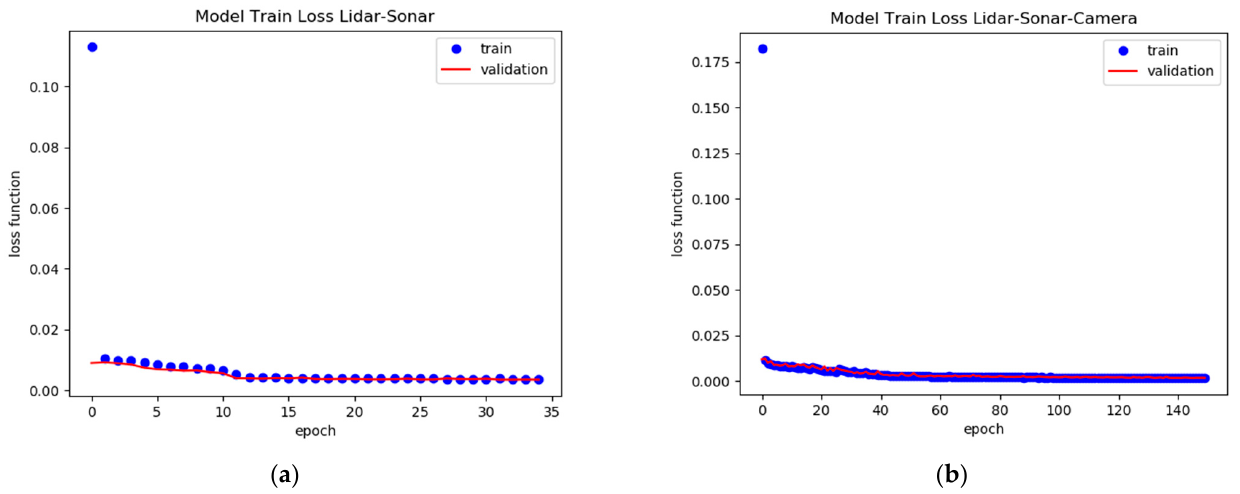
Figure 35. Model Validation Loss Function: ( a ) LiDAR-Sonar fusion; ( b ) LiDAR-Sonar-Camera fusion.